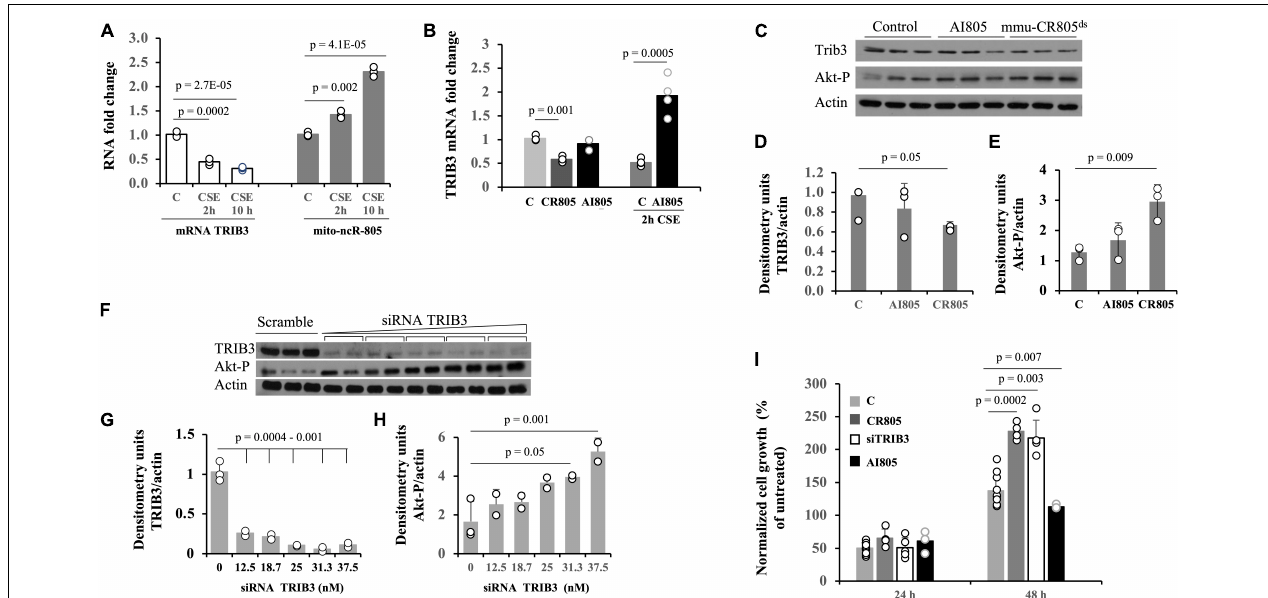
FIGURE 5 | Forced expression of mmu-CR805 results in lower abundance of Akt kinase inhibitor, TRIB3 mRNA. (A) The MLE12 cells were either exposed or not exposed to CSE, the RNA was extracted, and the expressions of TRIB3 and mmu-mito-ncR-805 were tested by RT-qPCR. (B–E) The MLE12 cells were transfected with mmu-CR805, AI805, or non-targeting RNA and were either stressed or not on exposure to CSE, and RNA or proteins were extracted to assess the expression of TRIB3. (B) Levels of TRIB3 mRNA as evaluated by RT-qPCR. (C) Levels of TRIB3 protein and Akt1 phosphorylation as evaluated by Western blotting. Graphs represent quantification of TRIB3 protein levels (D) and Akt1 phosphorylation (E) . (F–H) The MLE12 cells were transfected with either increasing concentrations of siRNA against TRIB3 (in duplicates [TRIB3 Silencer Select S105984]) or with non-targeting siRNA, and the efficiency of TRIB3 depletion was tested by evaluating TRIB3 protein levels via Western blotting. Since TRIB3 inhibits the activation of prosurvival kinase Akt1, the Akt kinase activation/phosphorylation was used as an additional parameter to evaluate TRIB3 downregulation. Actin was used as a loading control. Graphs represent quantification of TRIB3 protein levels (G) and Akt1 phosphorylation (H) ; 25 µ M of siRNA against TRIB3 was chosen for further experiments. (I) The MLE12 cells were transfected with mmu-CR805, siRNA-TRIB3, AI805, or non-targeting RNA; 24 h post-transfection, the cell numbers were counted to ensure that pre-smoke cell numbers did not differ between the groups. No significant changes were observed, as expected from the data presented in Figure 2A . Twenty-four hours post-transfection, the cells were either exposed or not to 10% of CSE for 30 min, washed, and returned to grow in their regular medium; the cell counts were recorded 24 and 48 h after exposure to CSE. All experiments are representative of three independent experiments performed with triplicate